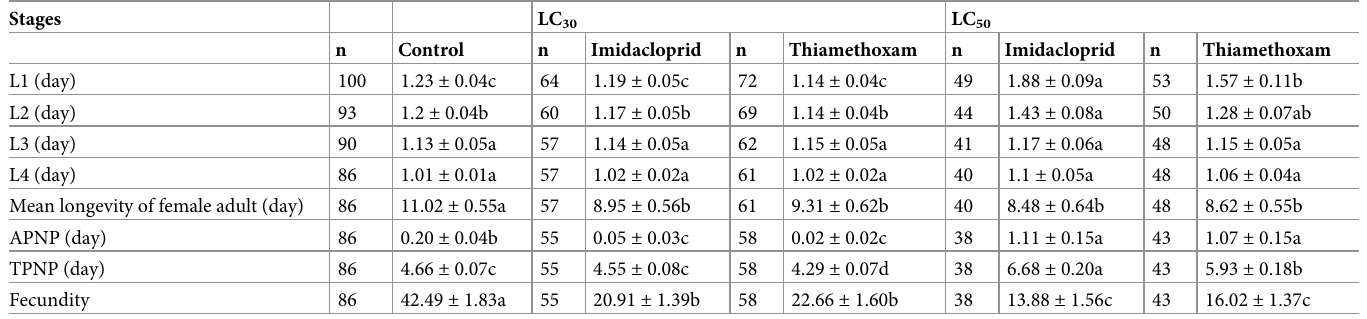
Means ( ± SE) followed by different letters in the same row are significantly different as calculated using the paired bootstrap test at the P < 0.05 level. Leaves treated with distilled water were used as the